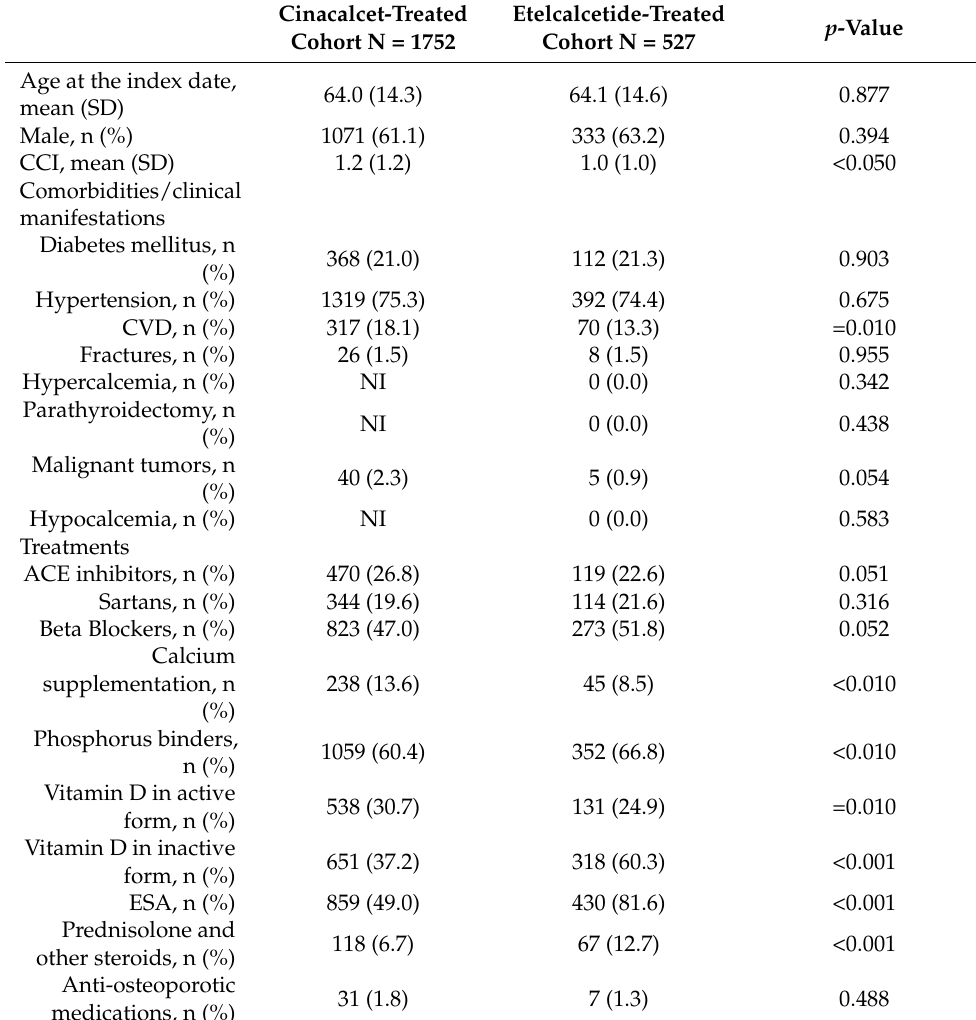
Table 1. Baseline characteristics of cinacalcet- and etelcalcetide-treated